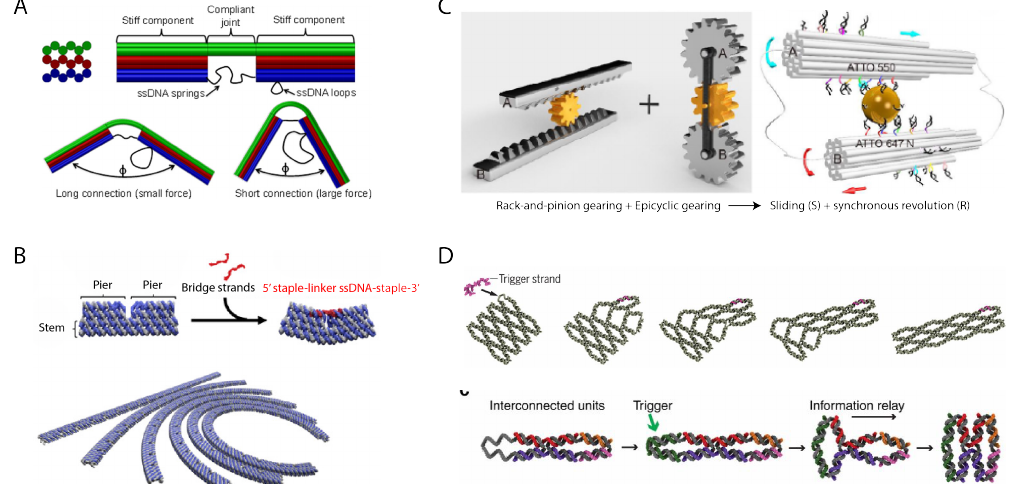
Figure 3. Nanomechanics implemented by DNA nanostructures. ( A ) Controlled angle of a hinged DNA nanostructure via an elastic ssDNA spring (reprinted with permission from ACS Publications [61]); ( B ) Modular deformation of a long DNA origami bundle. Linker strands span piers to induce local bending, which sums to global curvature (reprinted with permission from Wiley-VCH [64]); ( C ) Rotational and sliding gear motions of DNA origami bundles with respect to a central DNA nanorod (reprinted with permission from AAAS [53]); ( D ) DNA antijunction units composed into lattice arrays that transmit cascading changes through the structure (reprinted with permission from AAAS